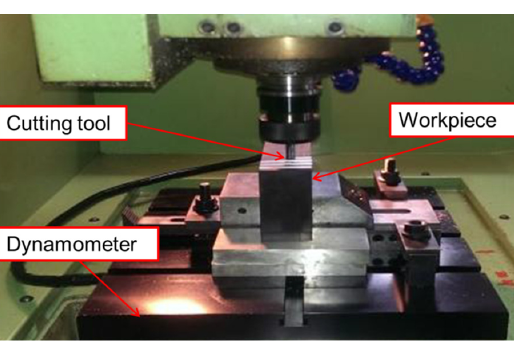
Figure 3. Experimental configuration for identification of cutting force coefficients.